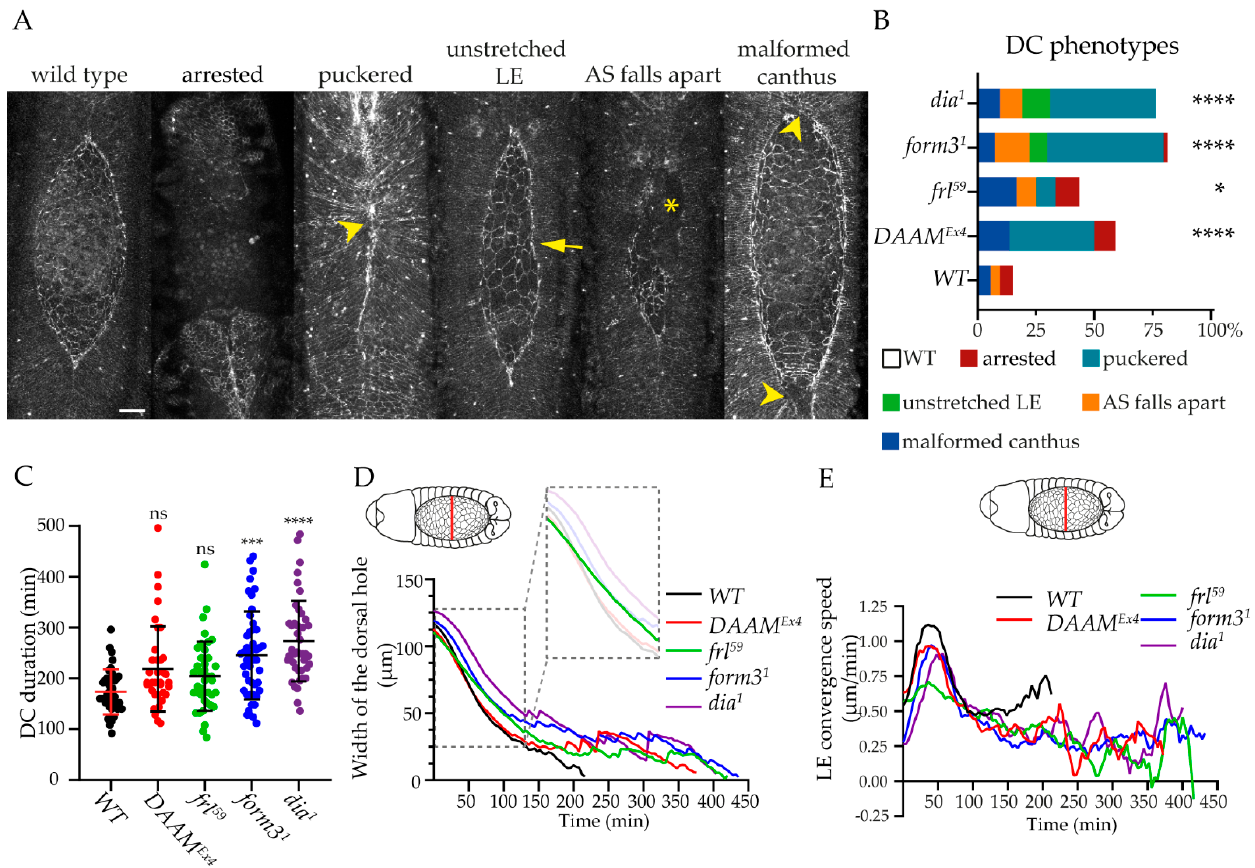
Figure 4. Comparison of the dorsal closure phenotypes in formin mutants. ( A ) Representative images of the dorsal closure phenotypes observed in Arm::GFP-expressing formin mutant embryos. Arrowheads point to the puckered dorsal midline and to the malformed canthi, an arrow indicates the unstretched DME, and an asterisk marks the place of missing AS cells. Scale bar 20 µm. ( B ) Quantification of the morphological defects observed in formin mutant embryos during dorsal closure. The color code represents the previously described categories. Arm::GFP was used as the wild-type (WT) control in B – E , and the mutants were compared to the WT control in B – C . ( C ) Scatter dot plot of DC duration in the formin mutants. Values are mean ± SD. ( D – E ) Diagram of the temporal change in the width of the dorsal hole ( D ) and that of LE convergence speed ( E ) in formin mutant embryos. Values indicate the average of several embryos. The inset in D highlights the first phase of the process to illustrate that, in frl mutants, the curve is linear, while it is sigmoid in all the other cases. For statistical analysis, we used the Chi-square test ( B ) and the Kruskal–Wallis test p < 0.0001, followed by Dunn’s multiple comparisons test ( C ); ns = non-significant. * p ≤ 0.05, *** p ≤ 0.001, **** p ≤ 0.0001.